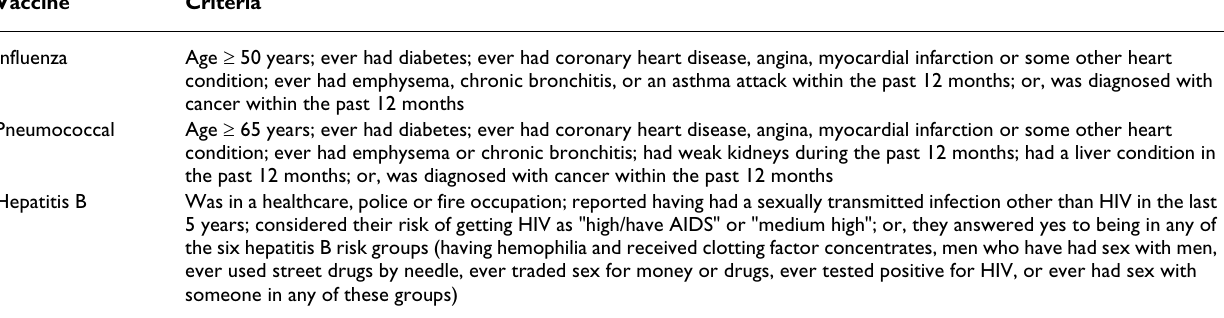
Table 1: Criteria used for classifying adults as high priority for receiving select vaccines